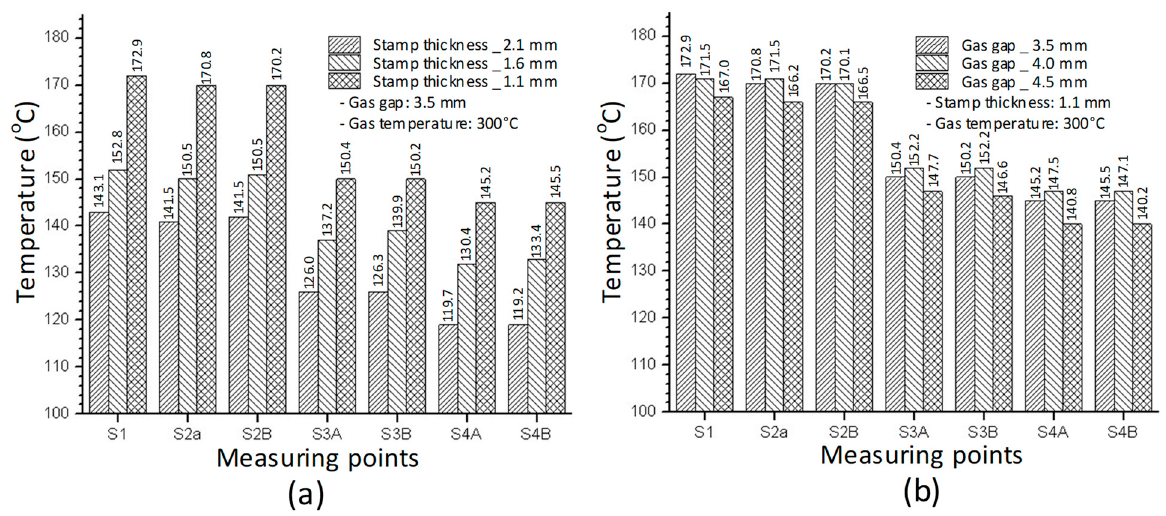
Figure 12. Temperature on the sensors in the simulation with different stamp thicknesses ( a ) and gas gap lengths ( b ).